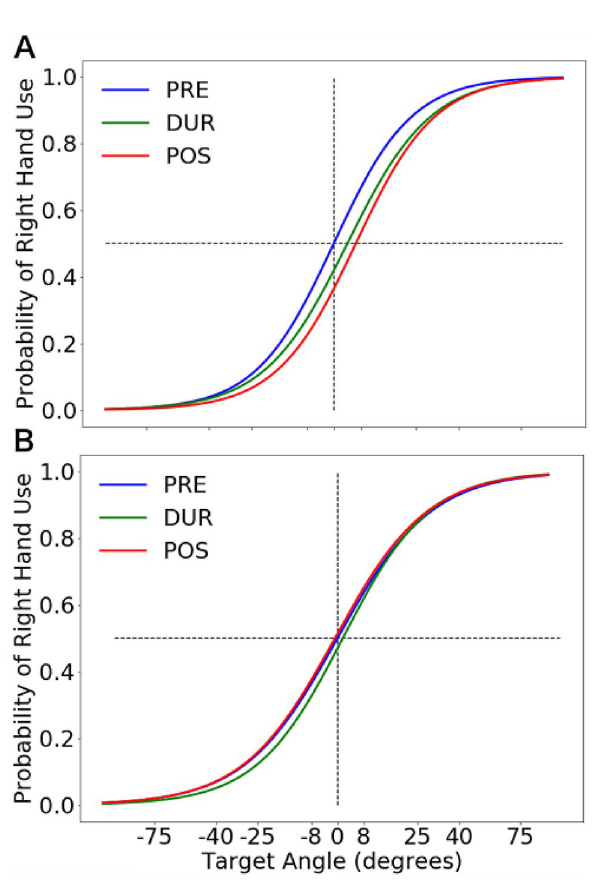
Figure 6. Logistic function was fitted to the probability of right-hand choice and averaged across the participants in the left cathode and right anode stimulation condition ( A ) and the left anode and right cathode stimulation condition ( B ). Blue-line, PRE phase; green-line, DURING phase; red-line, POST